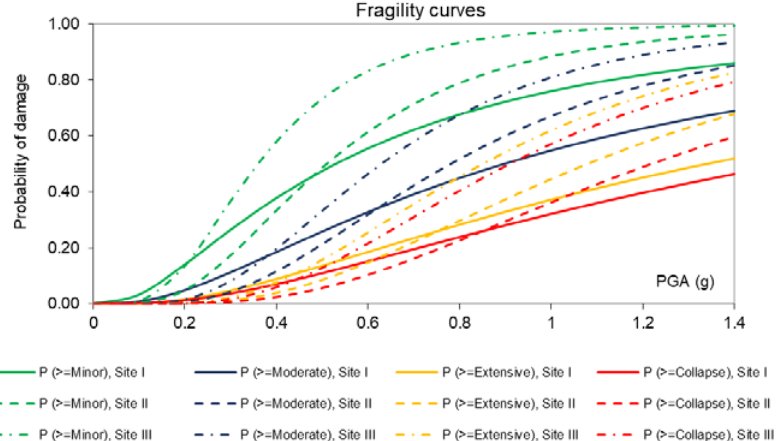
Figure 10. Analytical fragility curves proposed by Zhong et al. [89] developed for a two-story, three span subway station in alluvial for various damage states, assuming various conditions for surrounding ground.